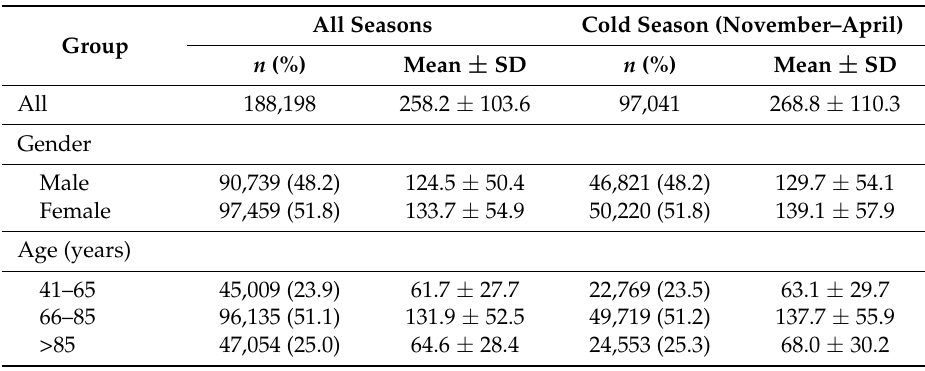
Table 1. Summary of daily IHD hospitalizations in Shanghai in 2013–2014.